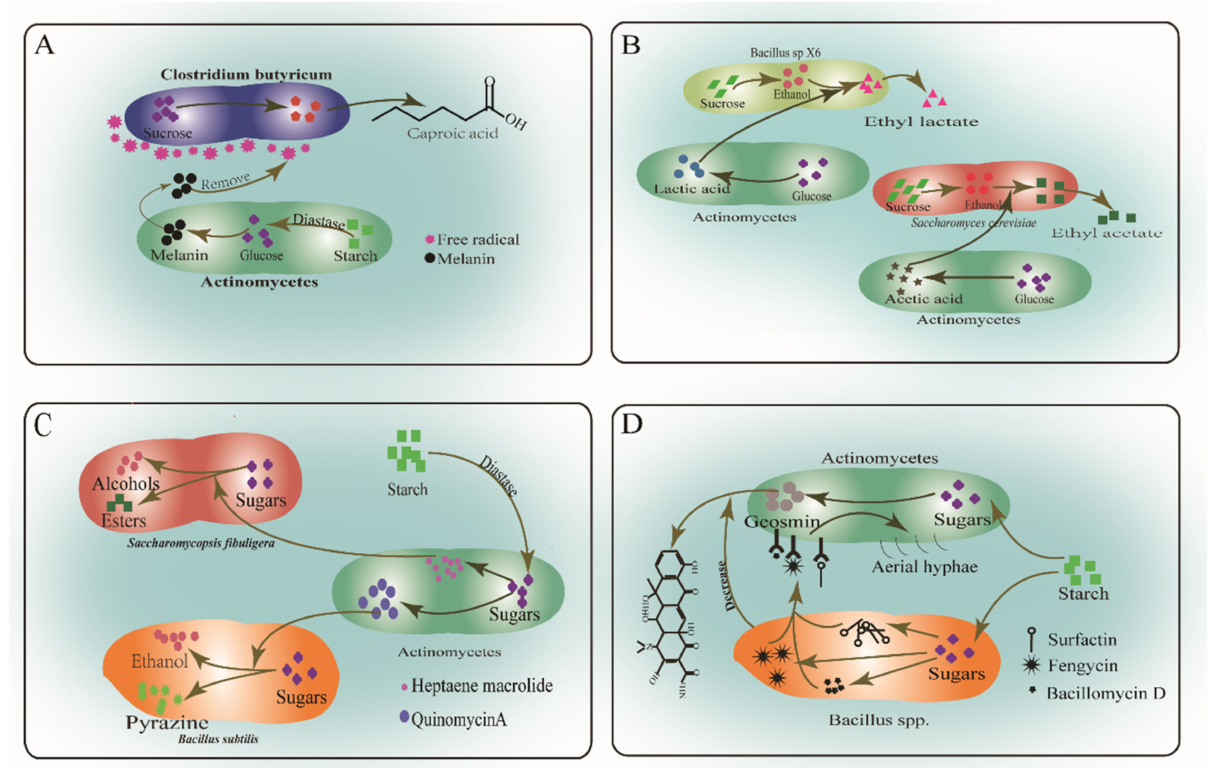
Figure 3. Interspecies interactions of actinomycetes. ( A ) Actinomycetes produce diastase to con- vertstarch into melanin that scavenges free radicals around C. butyricum . ( B ) Acetic acid and lactic acid produced by actinomycetes promote ethyl caproate and ethyl lactate production by yeasts and Bacillus . ( C ) Antibiotics produced by actinomycetes inhibit yeasts, promoting alcohol and pyrazine production by Bacillus . ( D ) Bacillus produces lipopeptides that inhibit the growth of Streptomyces and reduce geosmin